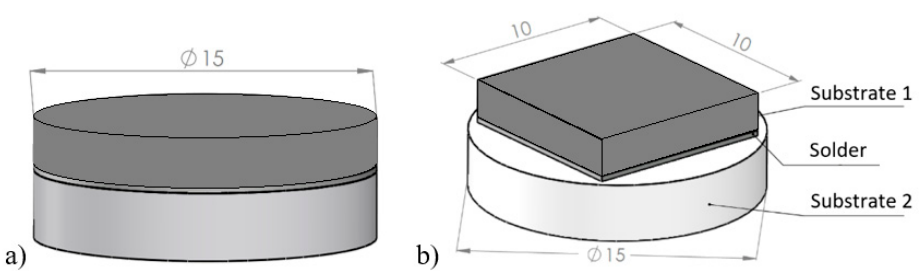
Figure 2. Setup of the soldered joint, ( a ) for analysis of substrate/solder/substrate boundaries, and ( b ) for shear strength measurement.